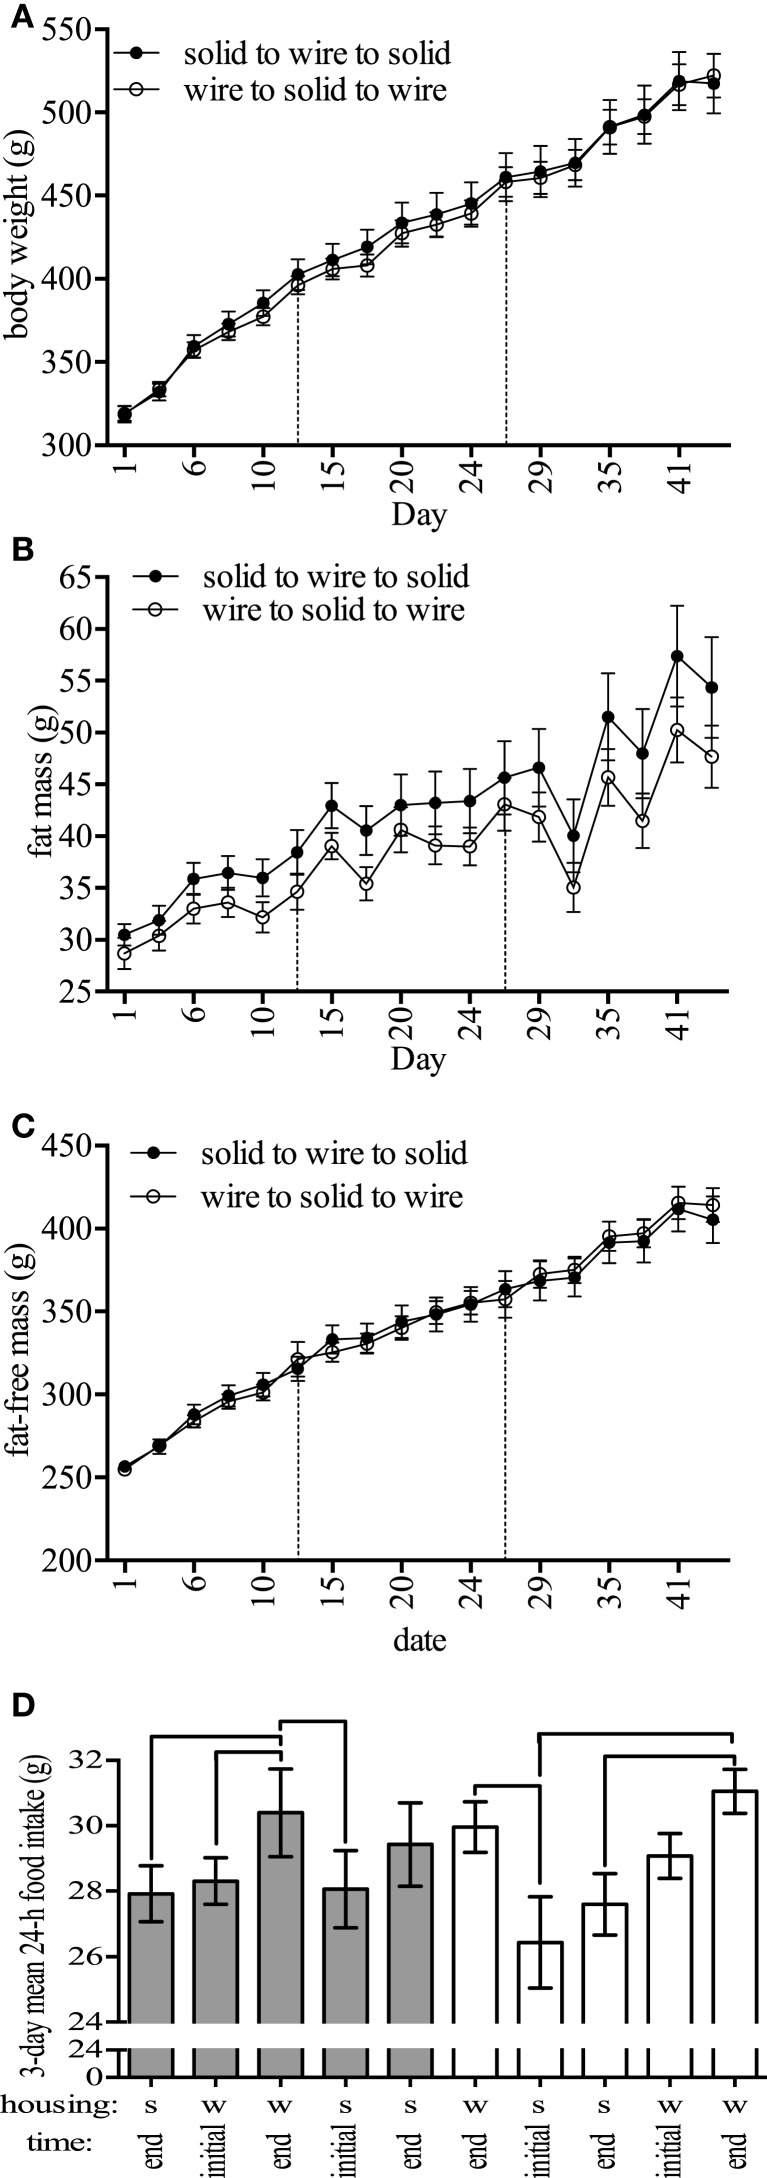
Body composition and feeding-related outcomes. (A) Body weight, (B) fat mass, (C) fat-free mass, and (D) 24-h food intake during 3-day periods at the beginning and end of 2-week periods in rodents housed in either solid (s)- or wire (w)-bottom cages for 2 weeks (days 1–14), moved to the other housing for 2 weeks (days 15–28), and then moved back to the original housing for 2 weeks (days 29–42). For food intake (D), note the decrease in food intake after switching from wire to solid cages. Data represent mean ± SEM. Please note different y-axes. N = 20 (n = 10/housing strategy). Lines above bars in (D) are significantly different.